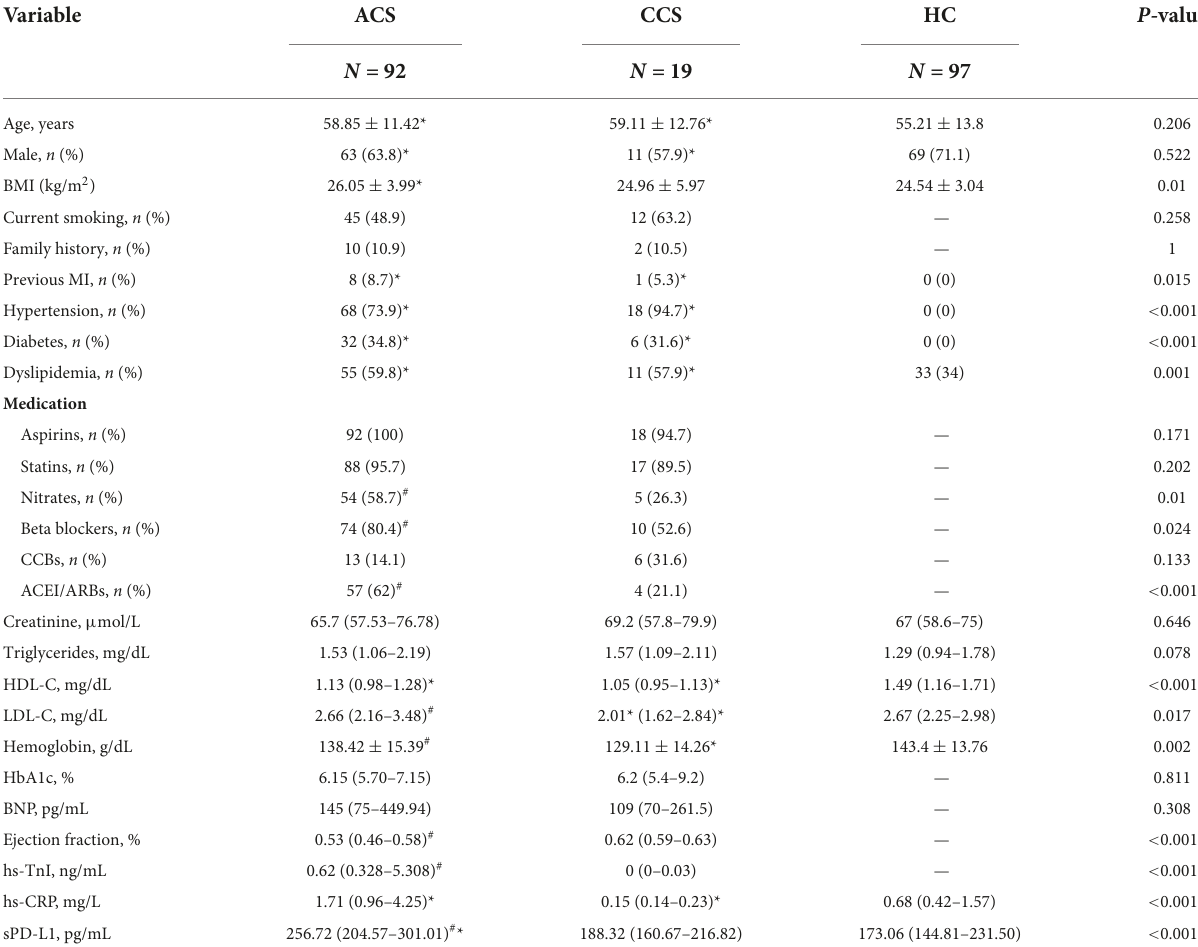
TABLE 1 Baseline characteristics of 111 enrolled